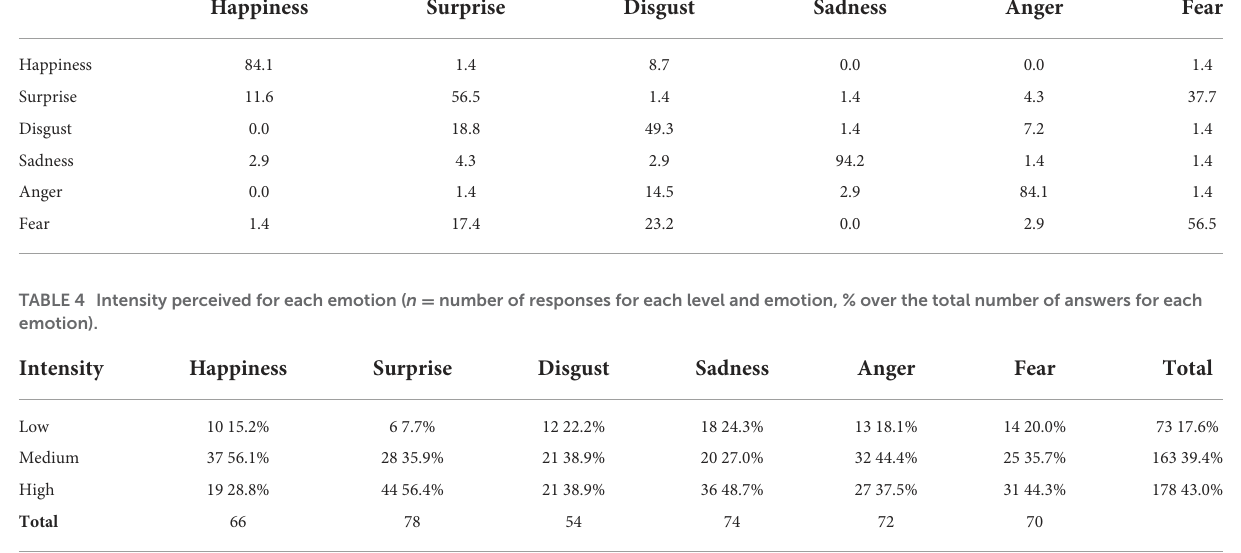
TABLE 3 Confusion matrix in emotion identification. Happiness